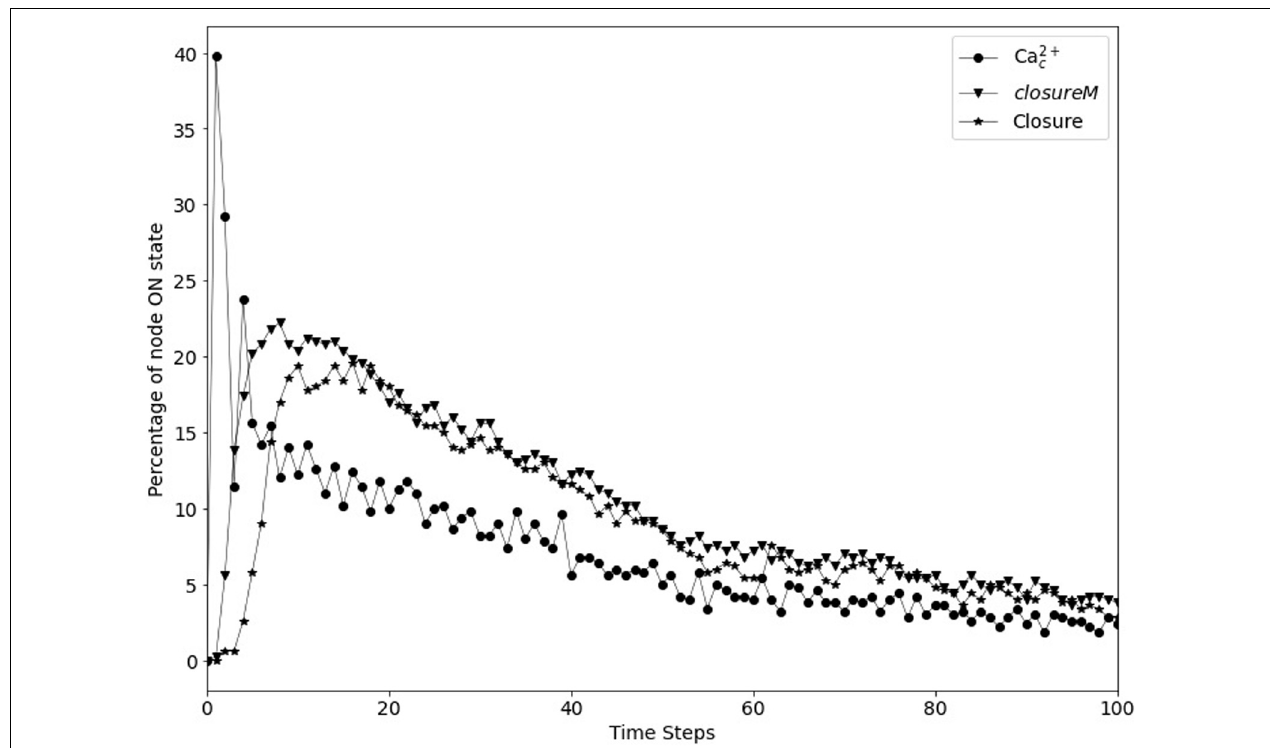
FIGURE 9 | Transient closure observed in Model1 in the absence of ABA when using short-term memory instead of node persistence. Due to the random initial conditions of the 17 nodes, the closureM motif temporarily stabilizes in ∼ 29% of the simulations (downward triangles) and there is a non-zero level of Ca 2 + c oscillations, which in turn lead to up to ∼ 20% transient closure. Eventually, the percentage of closure reduces to less than